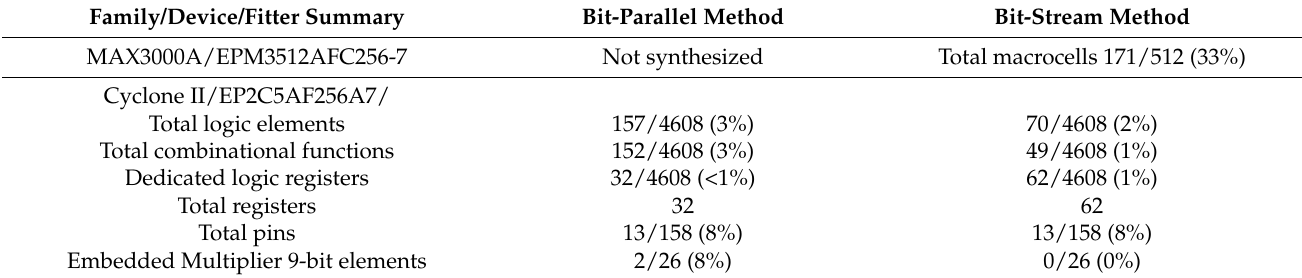
Table 2. Bit-parallel and bit-stream method